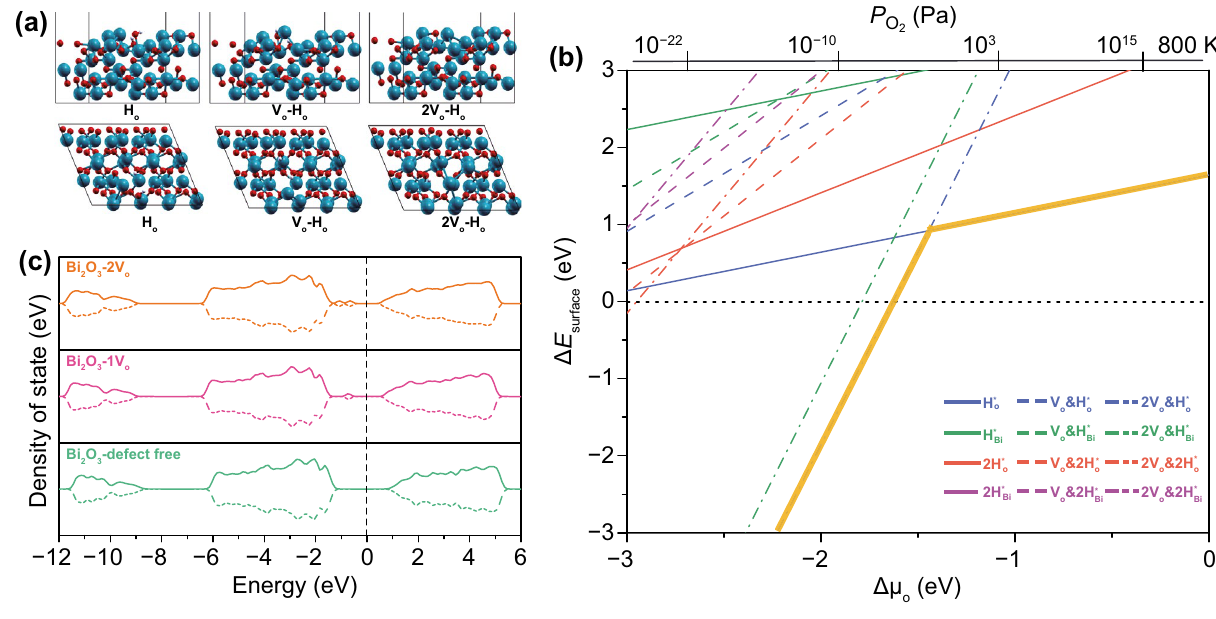
Fig. 6 DFT calculations on the formation and stability of V o within Bi 2 O 3 . From left to right, hydrogen atom adsorbed Bi 2 O 3 (010) surface models in defect-free state and with one or two oxygen vacancy incorporated ( a ), the calculated relative surface energies as functions of the chemical potential of oxygen (∆ μ O ) ( b ), and the spin-polarized electronic density of states of Bi 2 O 3 surfaces with different oxygen vacancies coverage ( c